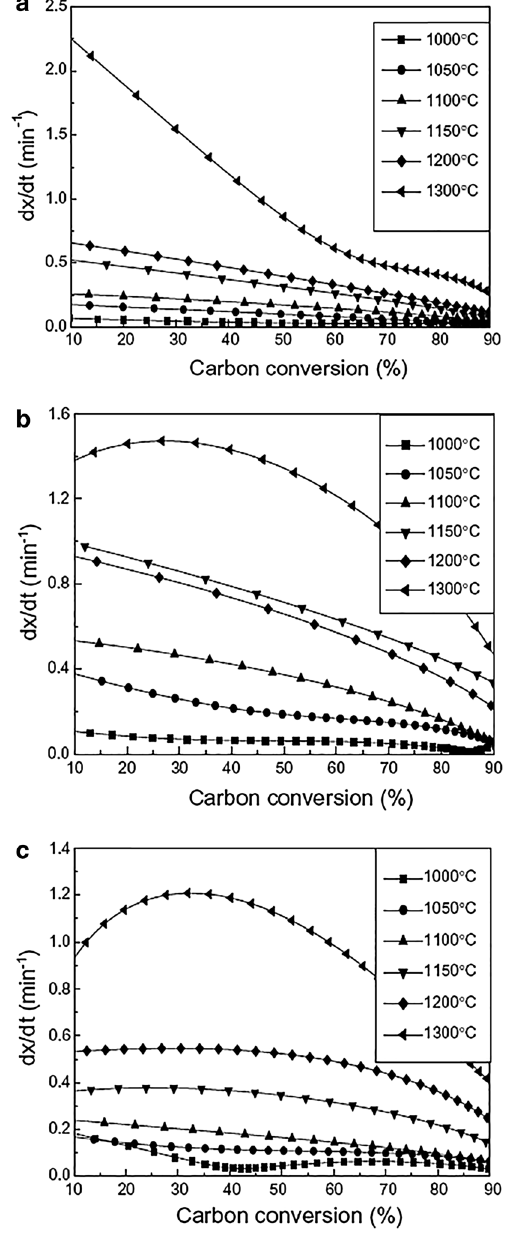
Fig. 5 Effect of temperature on gasification rate of char a SC, b RC, c RDC, Liu et al.